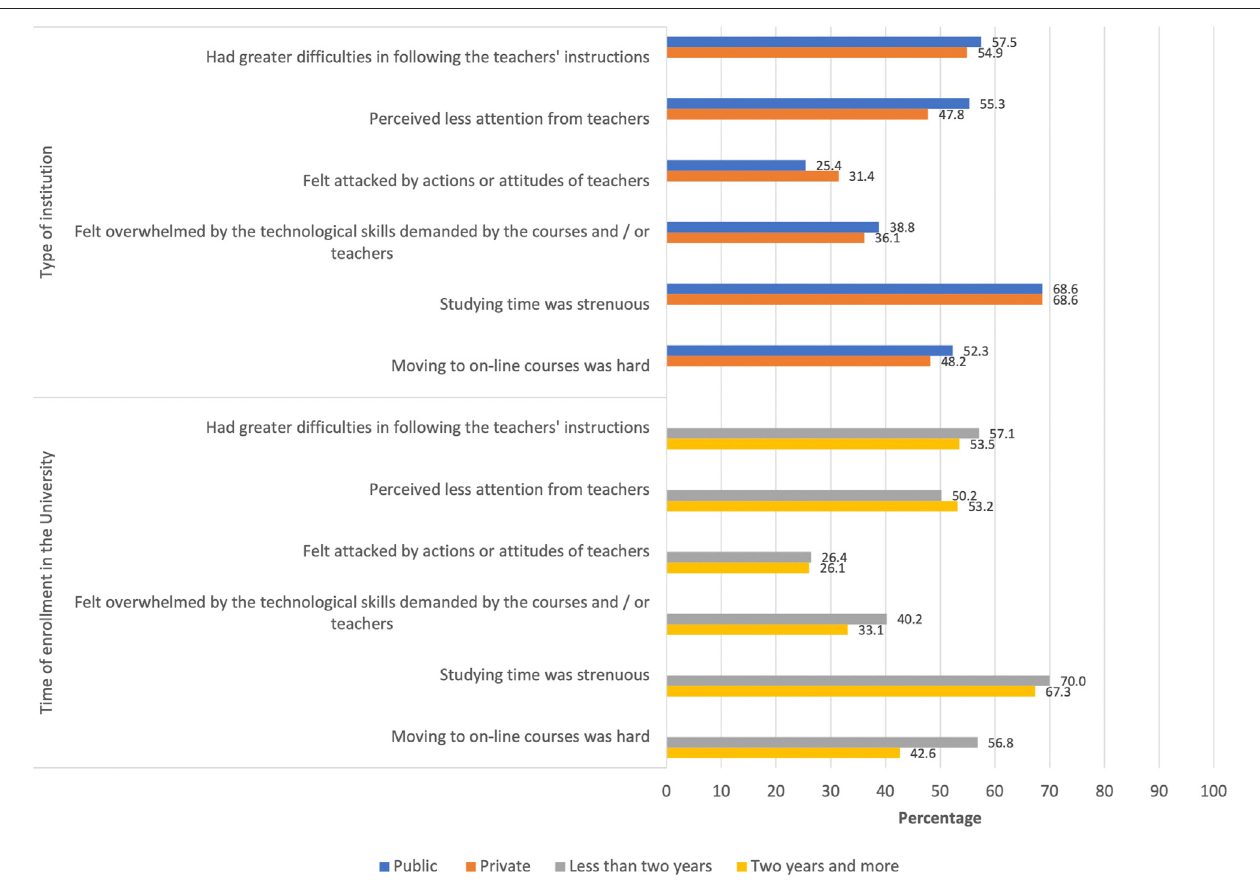
FIGURE6| Problemsfacedbystudentsduringtheemergencyremoteteachingmodelimplementation,bytypeofinstitutionandtimeofenrollmentintheuniversity.